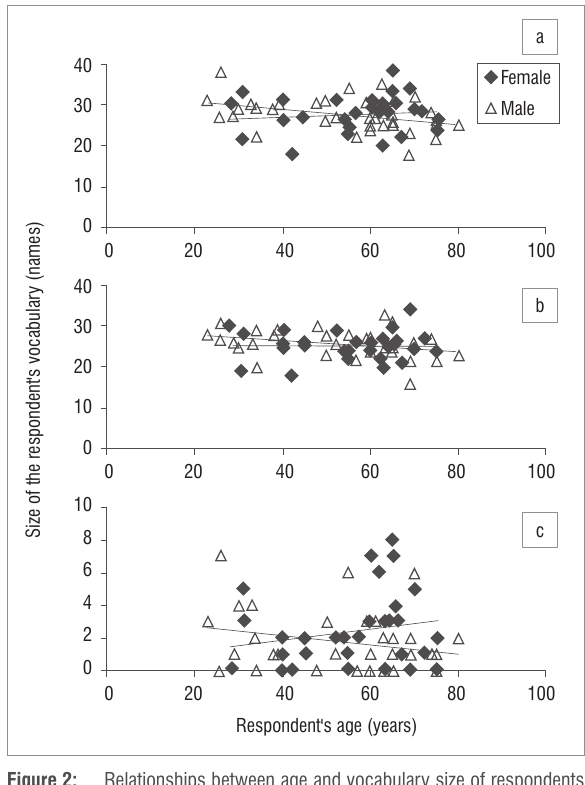
Figure 2: Relationships between age and vocabulary size of respondents in terms of (a) all names, (b) non-personal names and (c) personal names. The trend lines reflect the correlations reported in Table